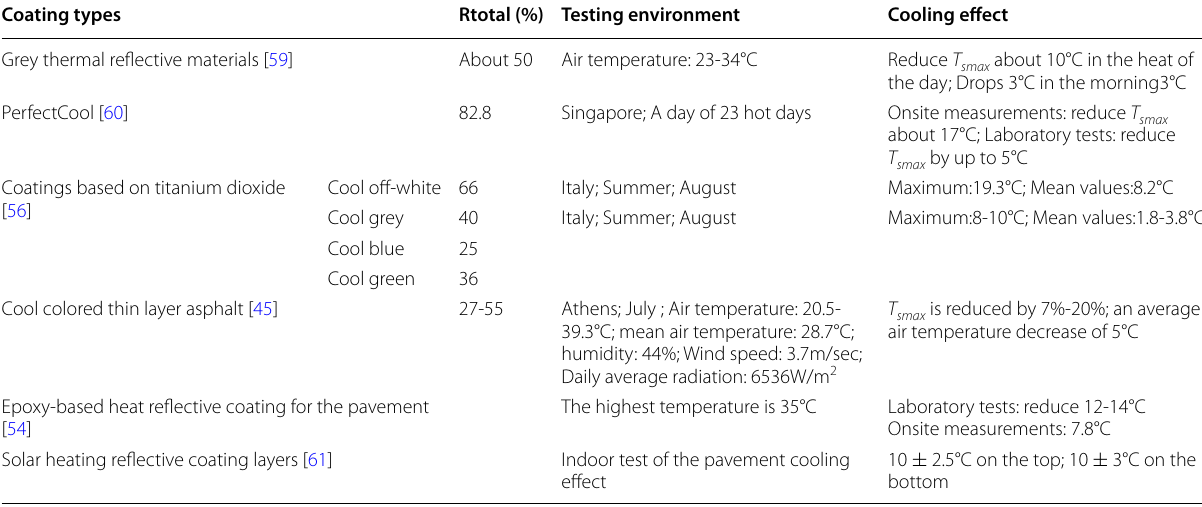
Table 2 Cooling effects of different heat-reflective coatings Coating